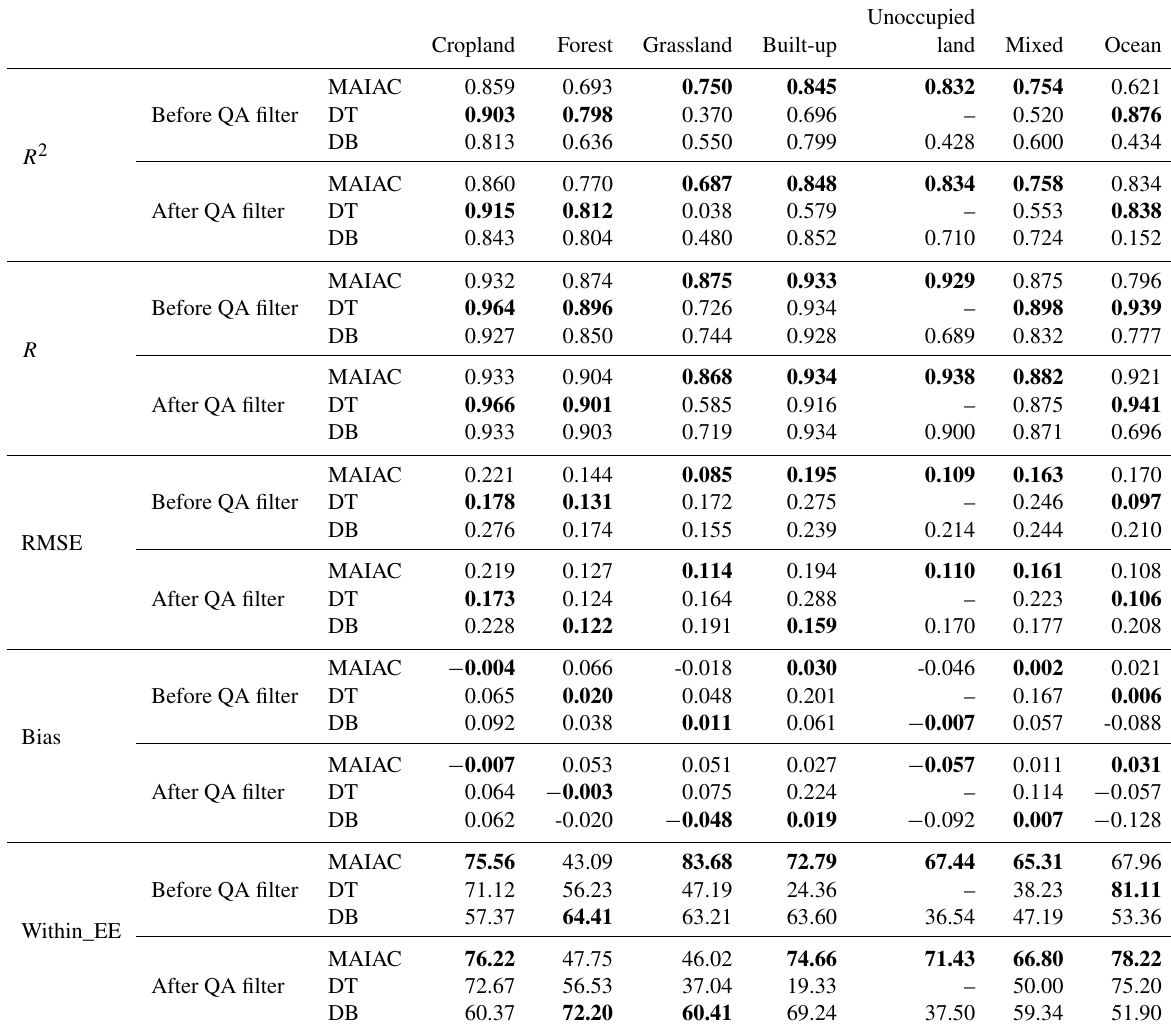
Table 4. Comparison of the retrieval accuracy of the MAIAC, DT, and DB products for different land cover types before and after the QA filter. “–” means no matchup pairs or that the matchup pairs number fewer than 10. The bold number is the highest peformance among three algorithms by each